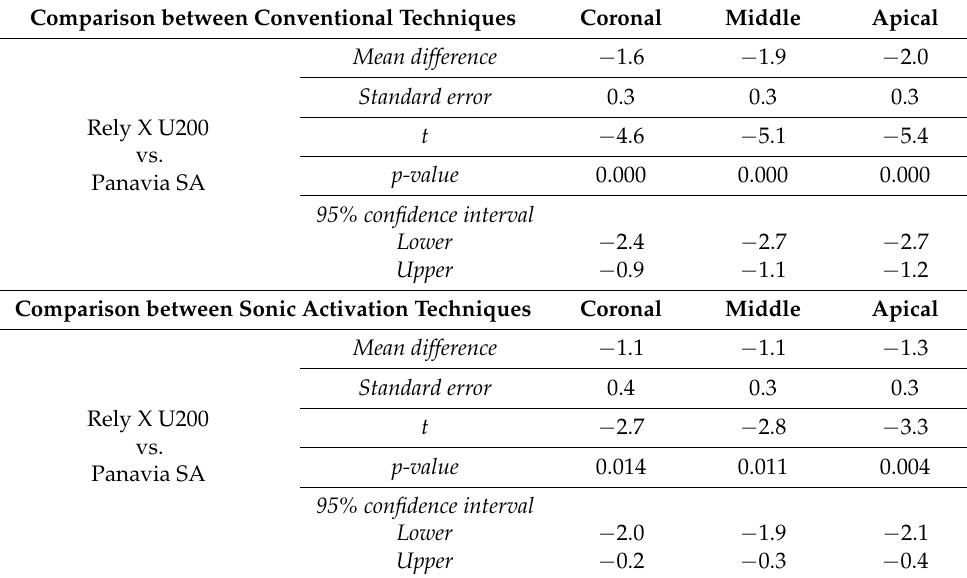
Table 3. Mean comparison of Panavia and Rely X U200 cements between techniques.